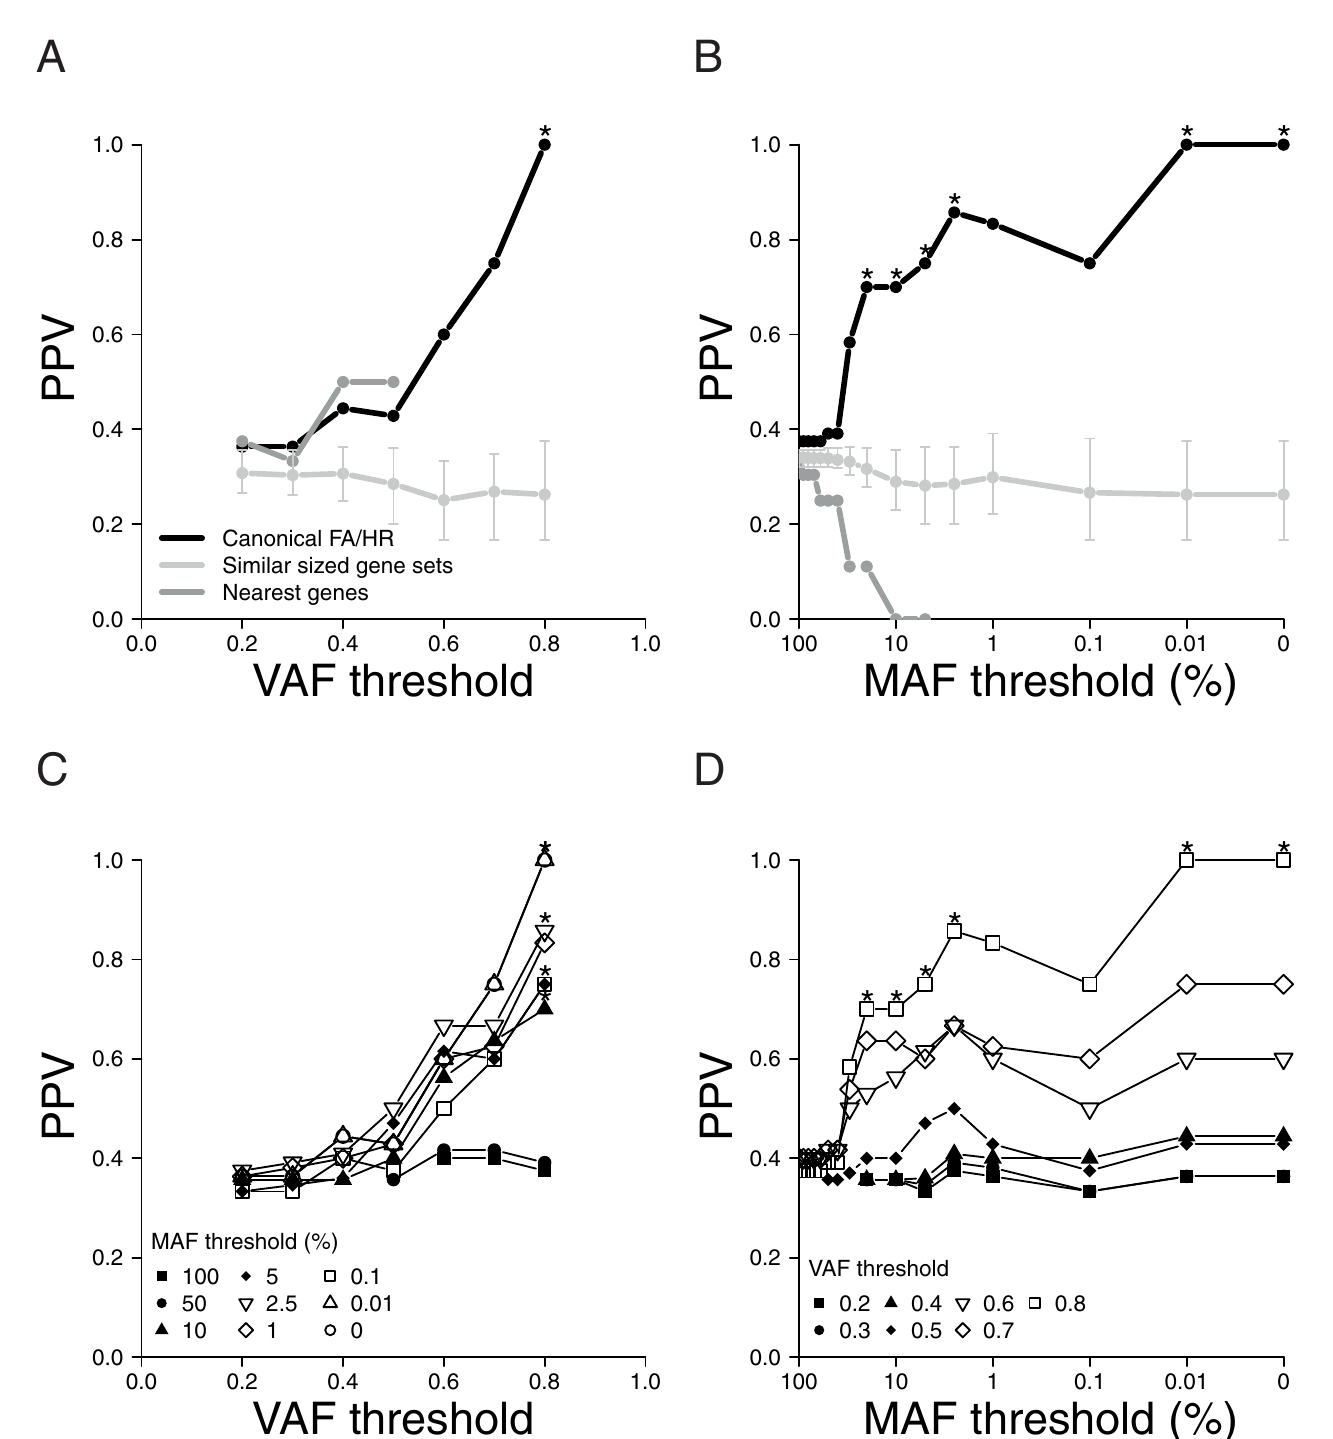
Fig 1. High VAF and low MAF selection criteria improve functional association. The positive predictive value (PPV) for MMC sensitivity was used to quantify the ability of variants to mark repair defected cell lines, i.e. ten most MMC sensitive, by the different variant selection criteria. Statistical analyses were omitted at sample sizes of a group of less than two and these data points and lines have been excluded in the figures. Asterisks mark a significant association with MMC response. (A) PPV values at each VAF threshold that was applied for variant selection are shown. Lines show the results for the canonical FA/HR genes and of the two controls: the “nearest genes” and the 10.000 similar sized randomly grouped gene sets. Error bars delineate the first and third quartile from the median in the latter. (B) PPV with progressively decreasing maximum MAF thresholds. Line coloring is identical to Fig 1A. (C) Impact of canonical